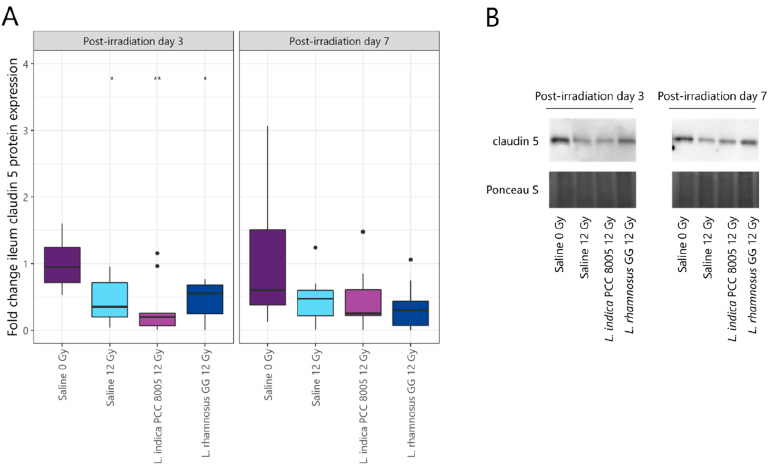
Figure 5. ( A ) Effects of pelvic irradiation on ileum claudin 5 protein expression. Outliers are depicted by dots, n = 10 per group. ( B ) Representative Western blot images of claudin 5 (23 kDa) and Ponceau S total protein staining, n = 10 per group, * p < 0.05 and ** p < 0.01 for pelvic irradiation-induced differences in respect to sham-irradiation by Kruskal–Wallis test (Dunn’s post hoc correction).